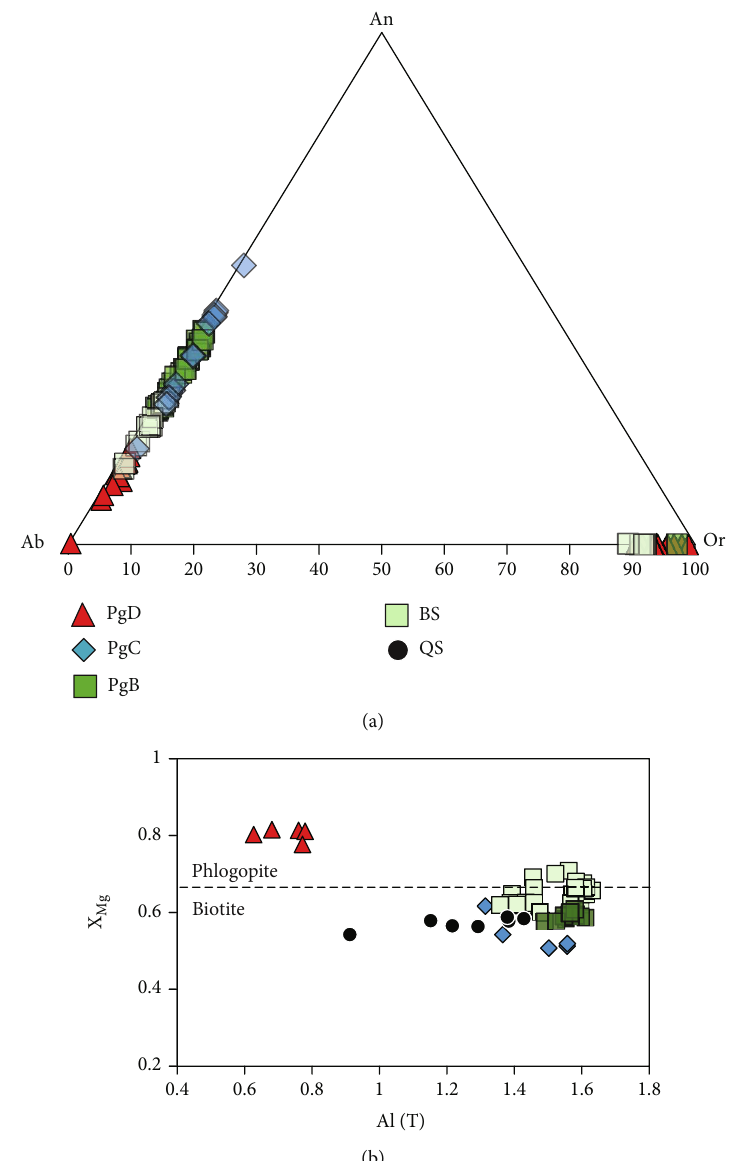
Figure 4: Compositions of plagioclase and biotite in the studied samples. (a) Ternary diagram of feldspar composition in pegmatite and biotite schist. (b) Al contents in the tetrahedral site and X values ( X = Mg/ ½ Mg + Fe tot Þ  ) of biotite in schist (per formula unit [p.f.u.]; Mg Mg O = 11 atoms ). Ab: albite; An: anorthite; Or: orthoclase; PgD: Qz diorite-hosted pegmatite; PgC: Cpx schist-hosted pegmatite; PgB: Bt schist-hosted pegmatite; BS: Bt schist; QS: Qz schist; POD: garnetite